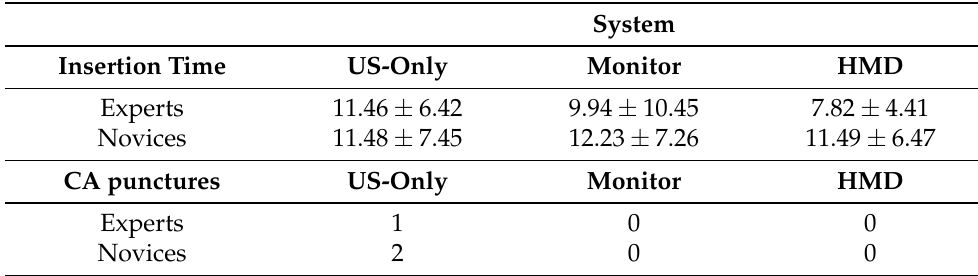
Table 4. Summary of insertion time and number of users who punctured the CA under each mode of visualization.